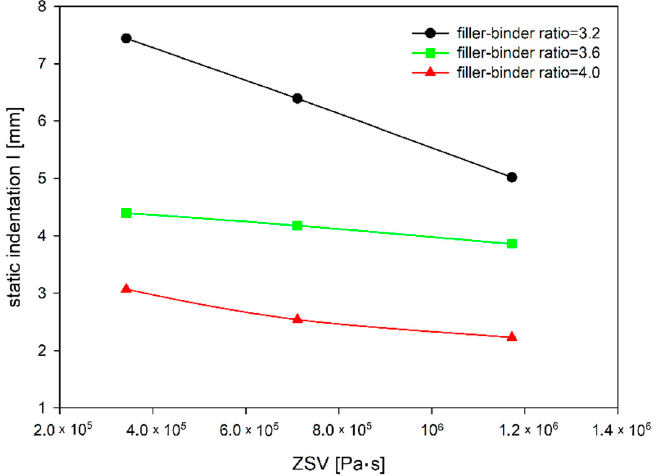
Figure 6. The dependence of MA static indentation on ZSV of TLA-modified binder for different filler–binder ratios.